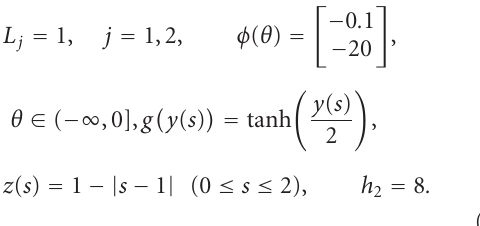
Figure 2: State responses of the closed-loop system for z 1 ( s ) = z 2 ( s ) = (